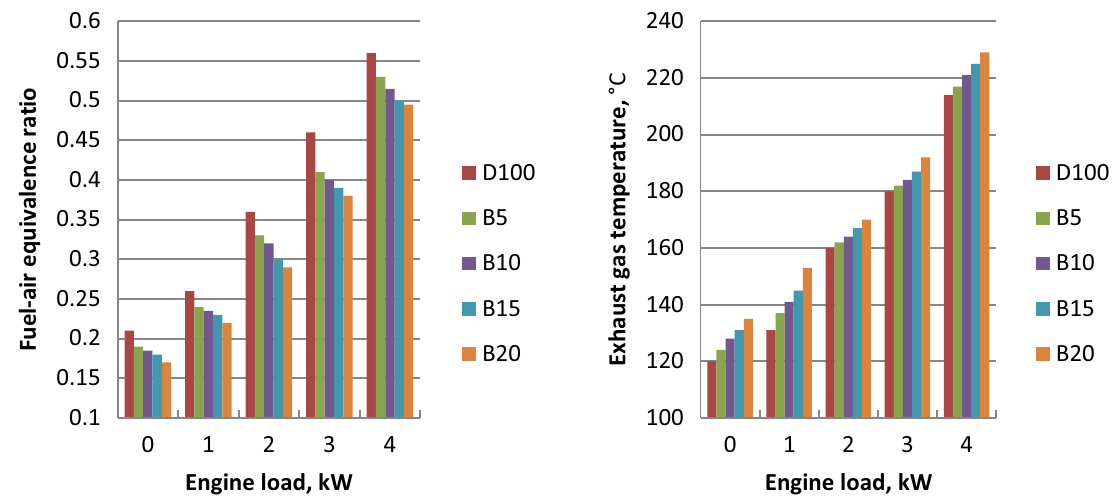
Figure 4. Fuel- air equivalence ratio and T exh variation against engine load.